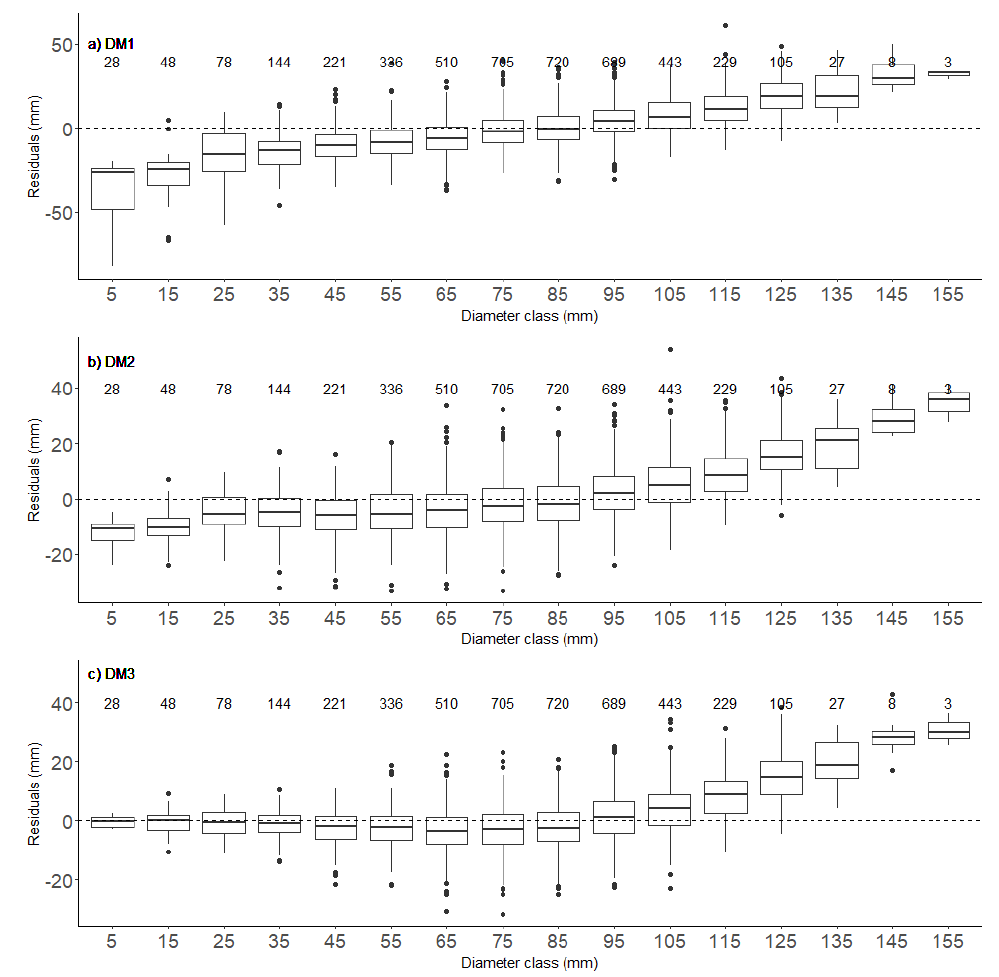
Figure 5. Box-plots of residuals (measured—estimated diameters) for the three diameter models (DM1—( a ), DM2—( b ) and DM3—( c )) in 10 dm height classes. Values above the boxplots are numbers of trees in corresponding 10 dm height classes. Table 1. Goodness-of-fit statistics for the hierarchical generalized additive (HGAM) models. Table 2. Summary statistics from the field and image-estimated measures in the trial.